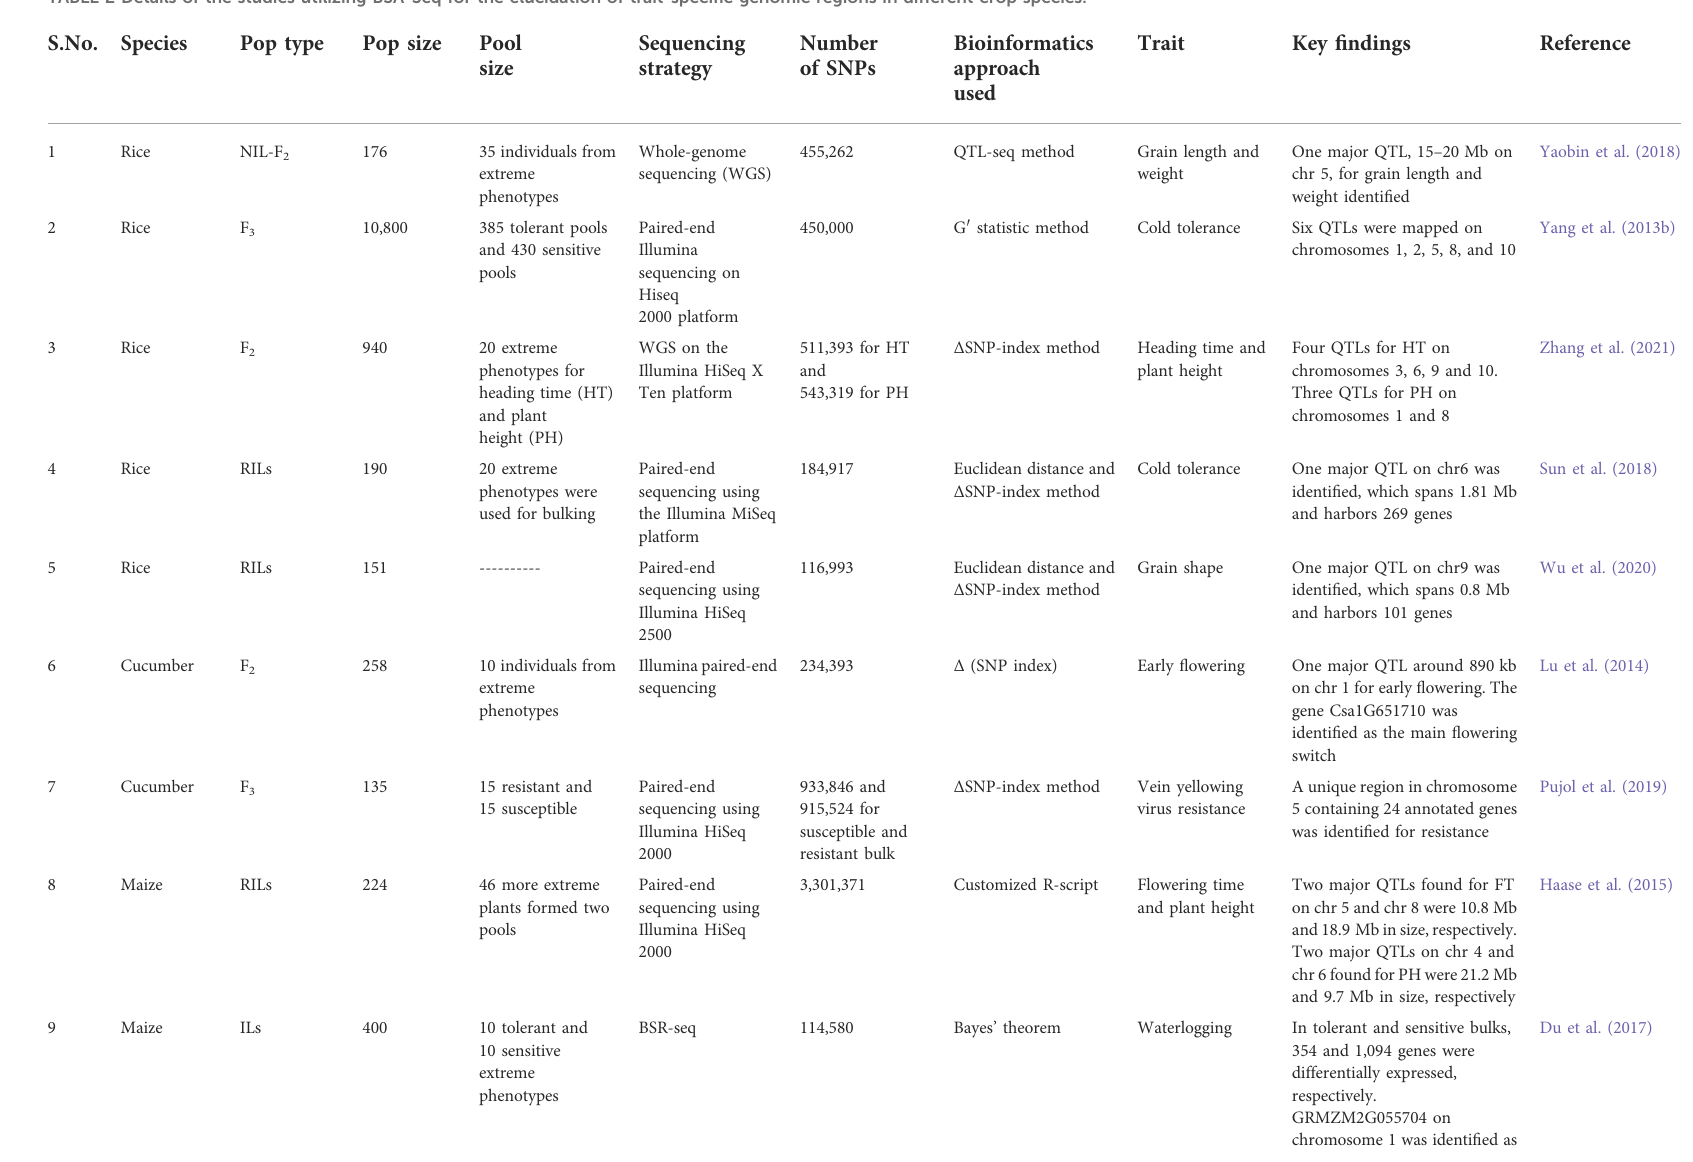
TABLE 2 Details of the studies utilizing BSA-Seq for the elucidation of trait-speci fi c genomic regions in different crop species. S.No.